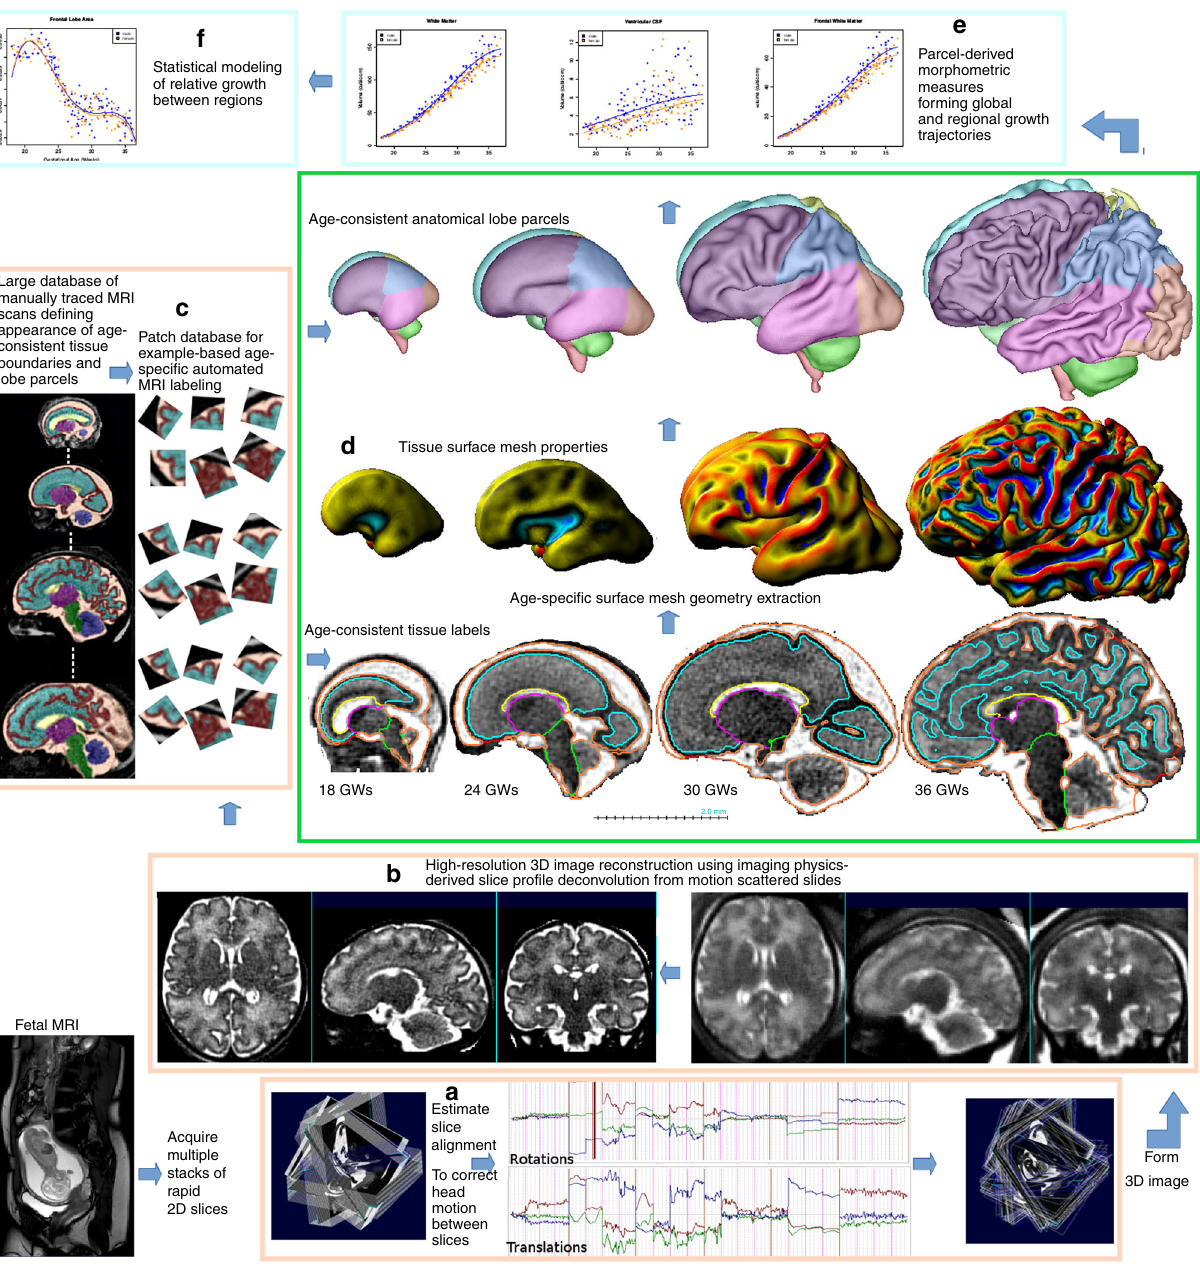
Fig. 1 Combining computationally assisted imaging and machine learning-based analysis allows large-scale studies of normal healthy volunteer pregnancies over a long gestational range with a high yield. Accurate motion correction ( a ) of fast multi-planar multi-slice MRI data 27,56 allows high spatial resolution (0.5 mm cubic voxels) 3D image ( b ) reconstruction 29 . Databases of expert delineated 3D images allow accurate and fully automated example-based tissue segmentation ( c ) into age-consistent classes, together with parcellation into lobe regions that can be tracked over long periods of development. Creation of surface representations at high resolution ( d ) allows mapping of subtle surface properties, such as local area and curvature to accurately quantify cortical development. Mixed-effects modeling of repeated measures ( e ) from fetuses allows fi tting of non-linear growth models and analysis of complex relative growth trajectories between local and global regions ( f